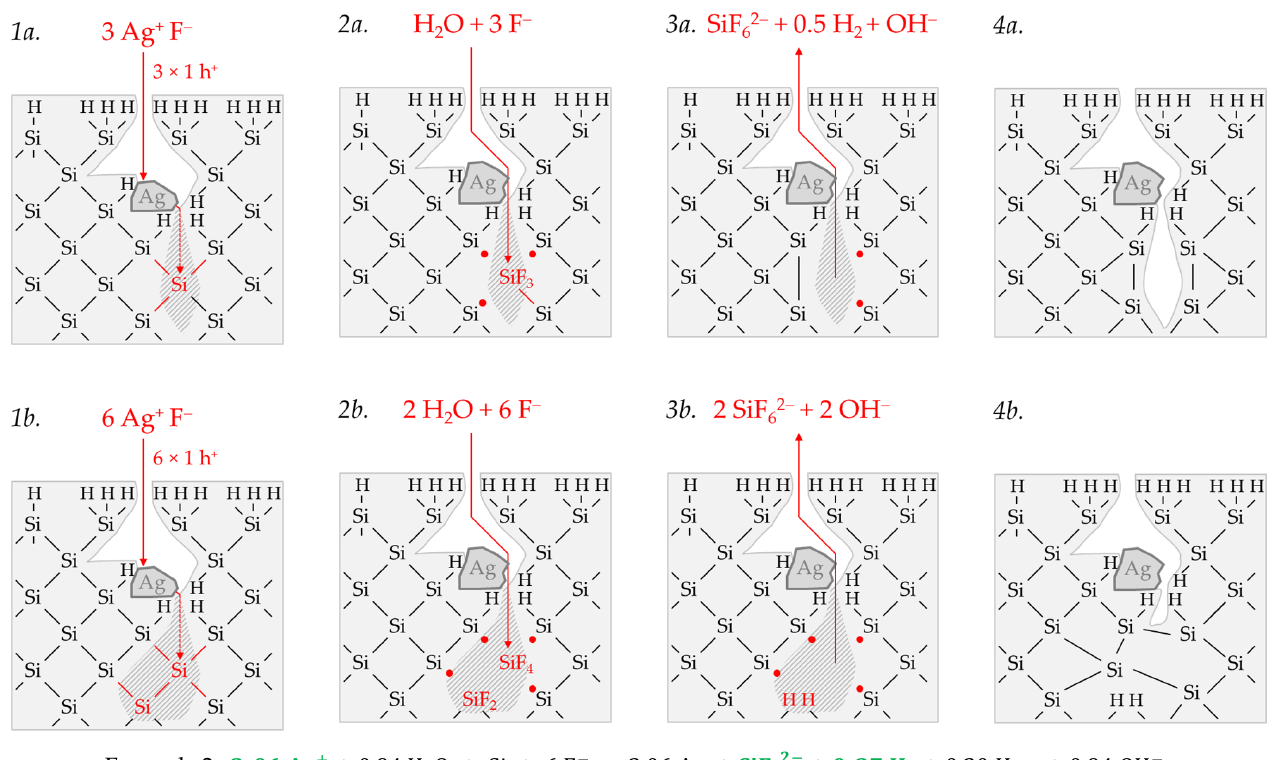
Figure 4. Schematic reaction process and balance of silver deposition on silicon, based on example 2 labeled in Figure 2e,f, with a Δ n Ag: Δ n Si: Δ n H 2 ratio of ≈ 3.06:1:0.37 mol:mol:mol.